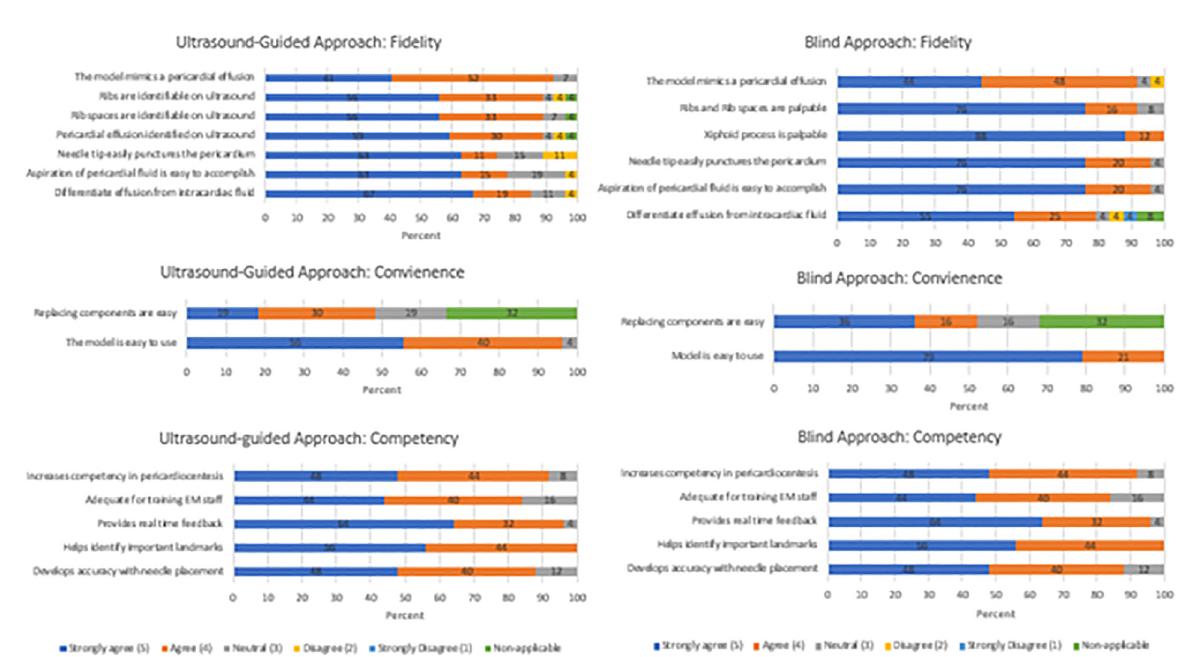
Figure 4. Results from the fidelity, convenience and competency questionnaire provided the participating residents. Values represent percentages. For the proportion of individuals that answered each subcategory refer to supplemental